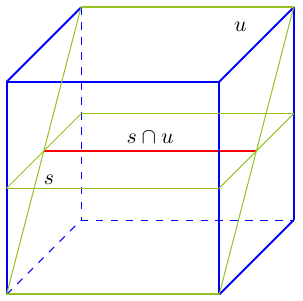
Figure 8 . Schematic picture of the space C 9 /G 26 . The green planes represent the fixed loci of the generators s and u . Each of these is codimension-1, and hosts a rank-1 theory. The red line is